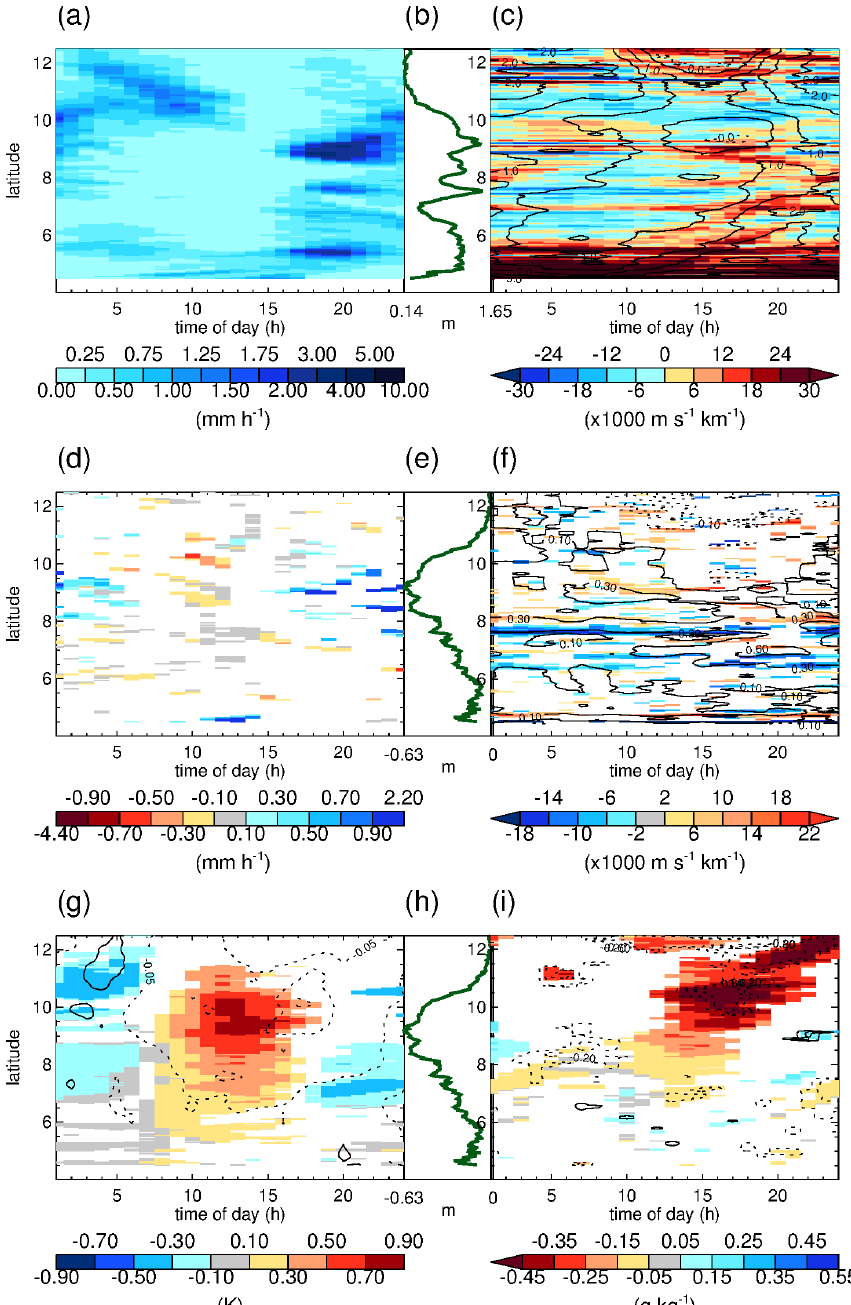
Figure 8. North–south cross sections averaged over 10–8 ◦ W over land. Diurnal cycles of (a) 1950s rain rate, (b) 1950s roughness length in- dicating 1950s forest, and (c) 1950s convergence of 10m winds (shading) and 1950s 10m meridional wind (black contours every 0.5ms − 1 ); changes in (d) rain rate, (e) roughness length indicating the extent of deforestation, (f) convergence of 10m winds (shading) with 10m merid- ional wind (black contours every 0.2ms − 1 ), (g) 1.5m temperature (shading) and surface pressure (black contours every 0.1hPa), (h) rough- ness length (repeat of e ), and (i) specific humidity (shading) with (cid:49)θ (black contours every 0.4K). Insignificant changes are shown in white, whereas small but significant changes either side of zero are shown in